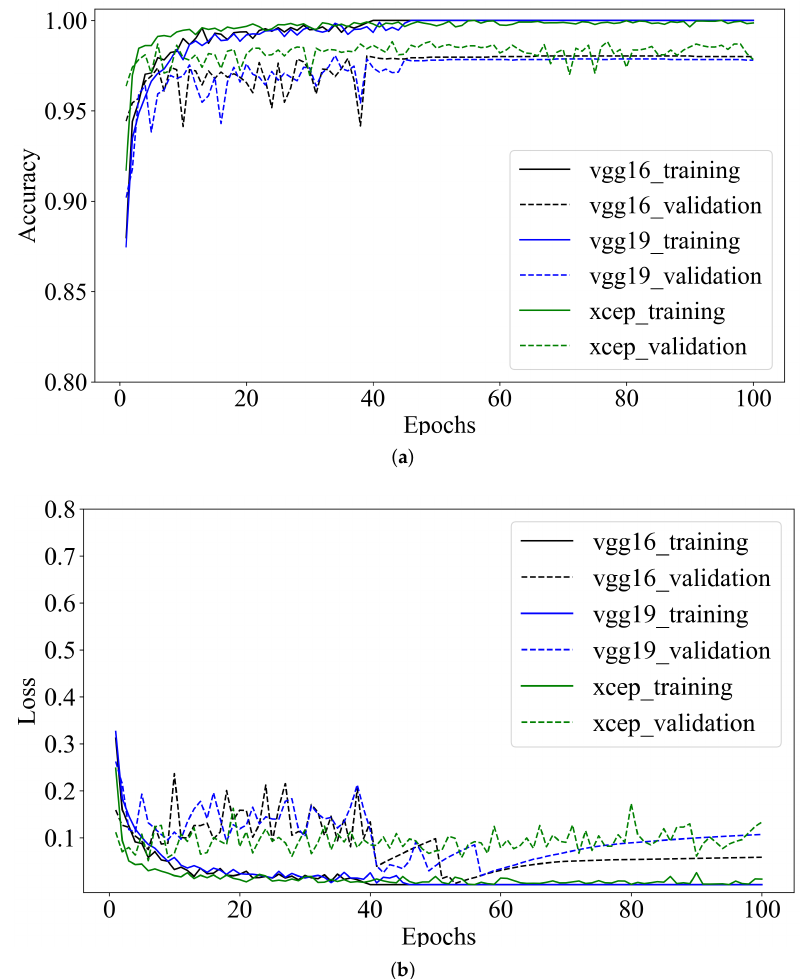
Figure 11. Graphs of behavior during training of VGG16, VGG19 and Xception. ( a ) Accuracy. ( b ) Loss